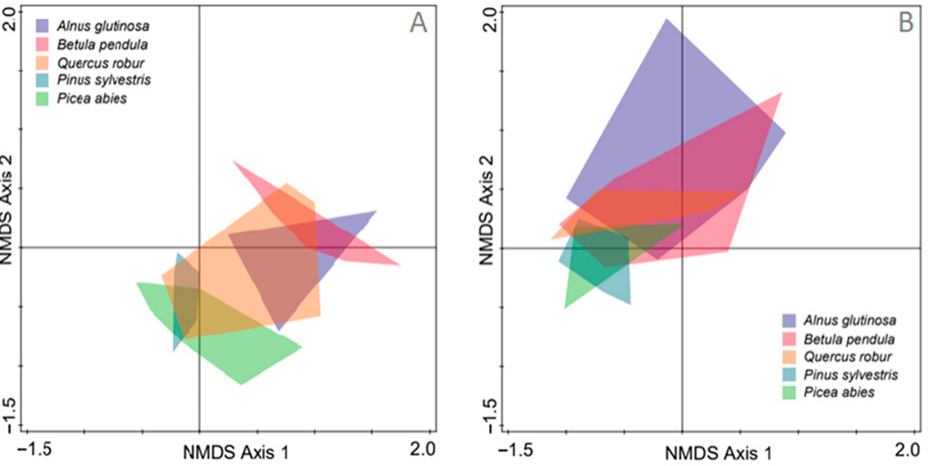
Figure 4. NMDS of the fungal and oomycete communities in the roots ( A ) and soil ( B ) of the five tree species grown in the forest nurseries. The data from the different forest nurseries are com- bined.